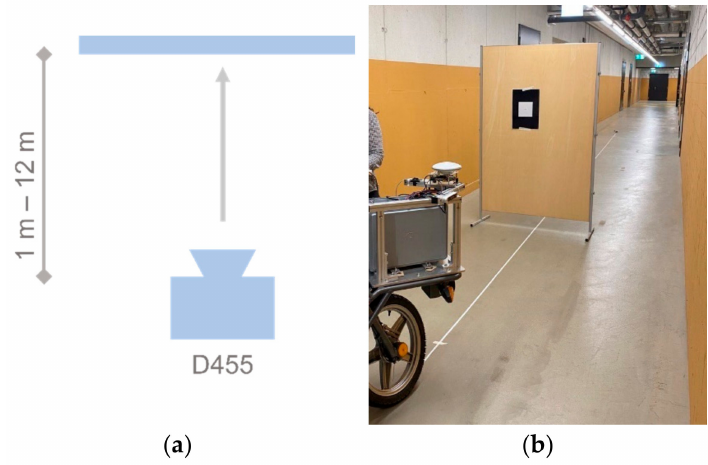
Figure 11. Indoor experimental setup for the performance evaluation of depth measurements: ( a ) illus- tration of the experimental concept; ( b ) practical setup for the evaluation of the left-facing 3D camera.